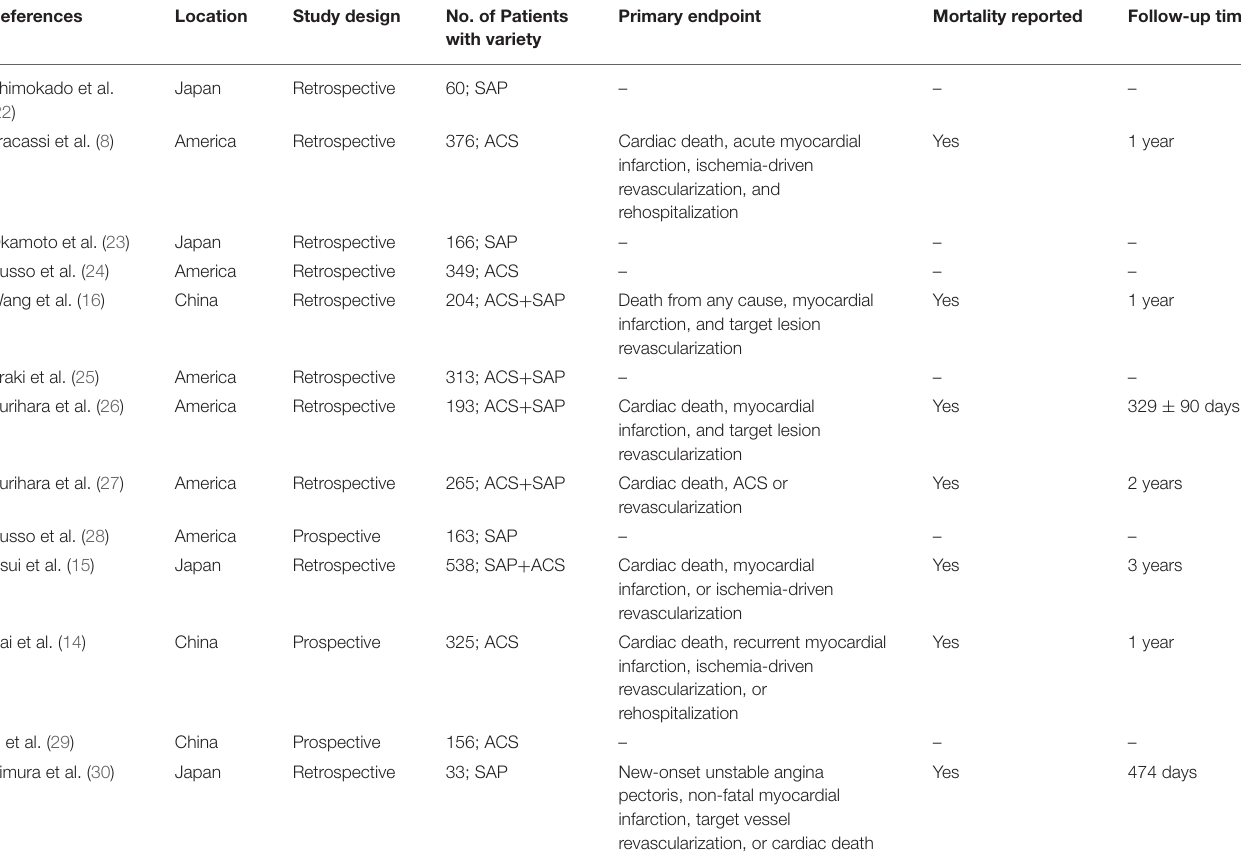
TABLE 1 | Characteristics of included studies.